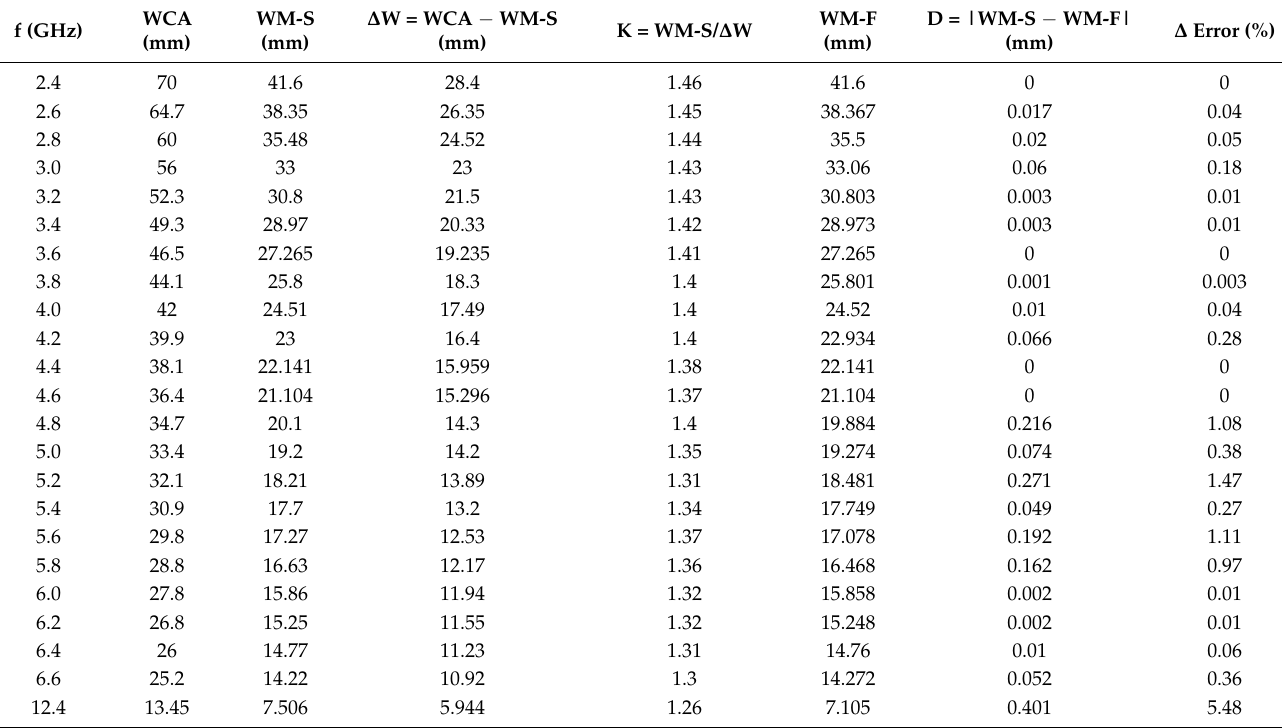
Table 6. Patch width estimation on Rogers RT/Duroid 5880 substrate using